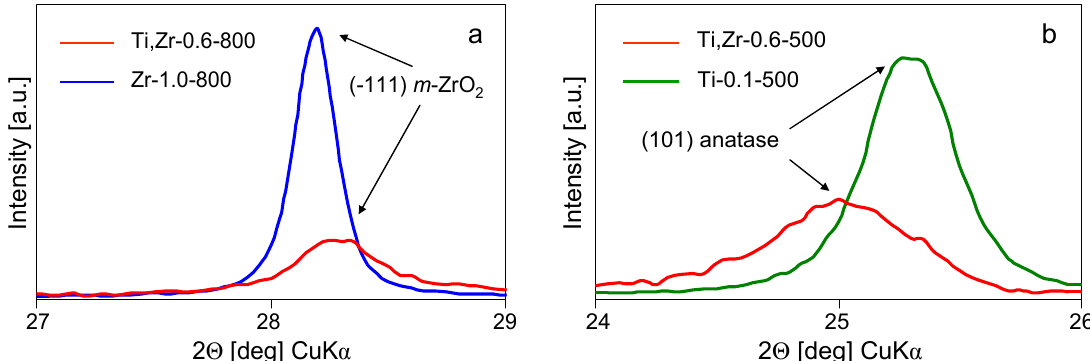
Figure 7. ( a ) Shift of (-111) XRD reflection of m -ZrO 2 to higher 2 Θ in multiphase Ti, Zr-0.6-800 with respect to its position in Zr-1.0-800, ( b ) shift of (101) XRD reflection of anatase to lower 2 Θ in multiphase Ti, Zr-0.6-500 with respect to its position in Ti-0.1-500.